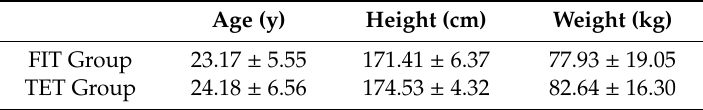
Table 1. Descriptive data of the participants, Mean ±